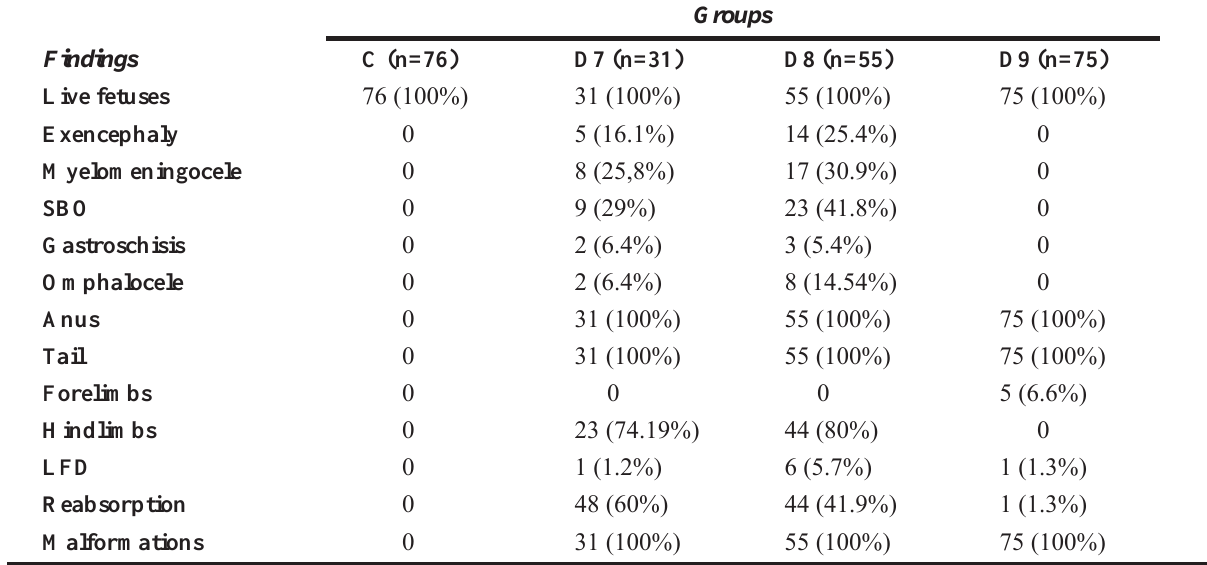
TABLE 1 - Results of treatment with retinoic acid in Swiss mouse fetuses on different gestational days. Number of live fetuses, late fetal deaths, reabsorptions and malformations on the different gestational days